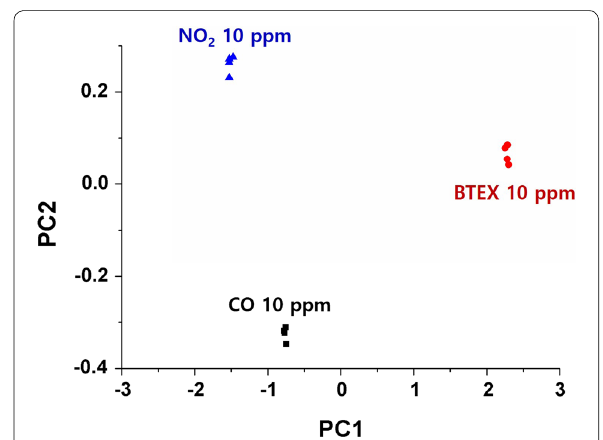
Fig. 7 PCA result for BTEX mixture, NO 2 , and CO